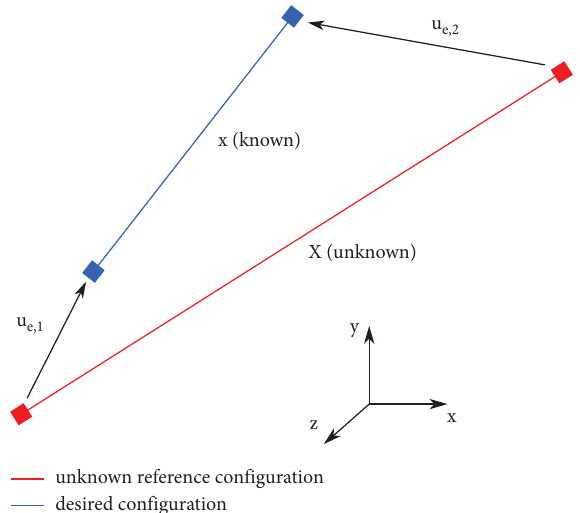
Figure 4: Unknown reference confguration deforms to the desired